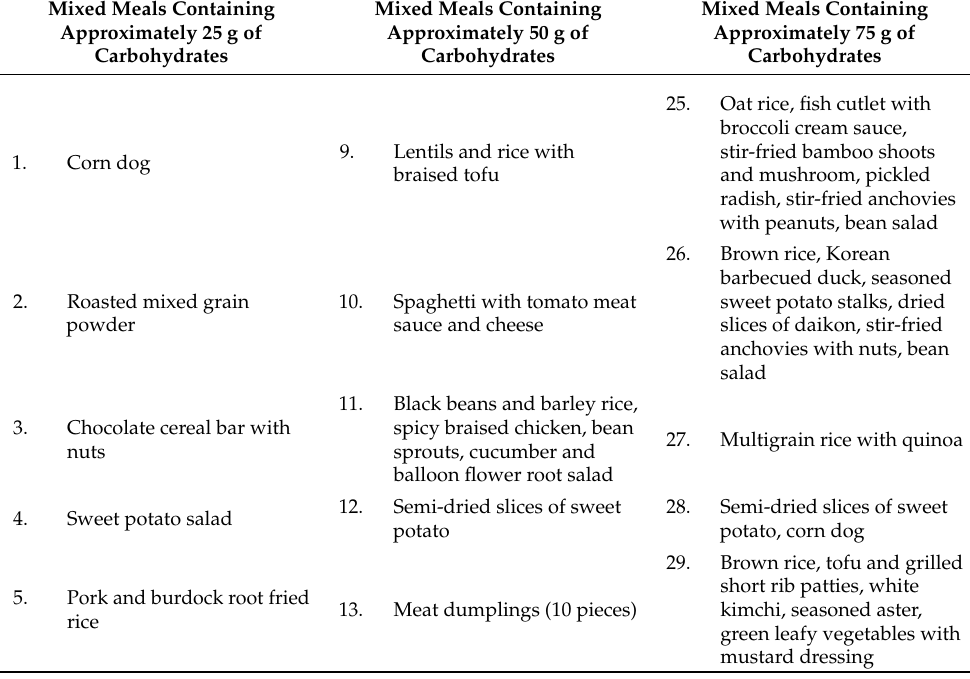
Table 1. List of 32 mixed meals based on fixed glucose amount and their ID